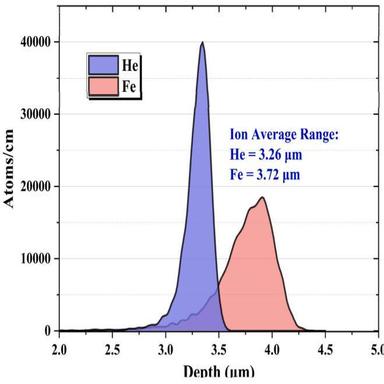
Penetration depths of He (blue peak) and Fe (pink peak) ions in the experimental material under the mono-nuclear energy of 0.5 MeV/u.